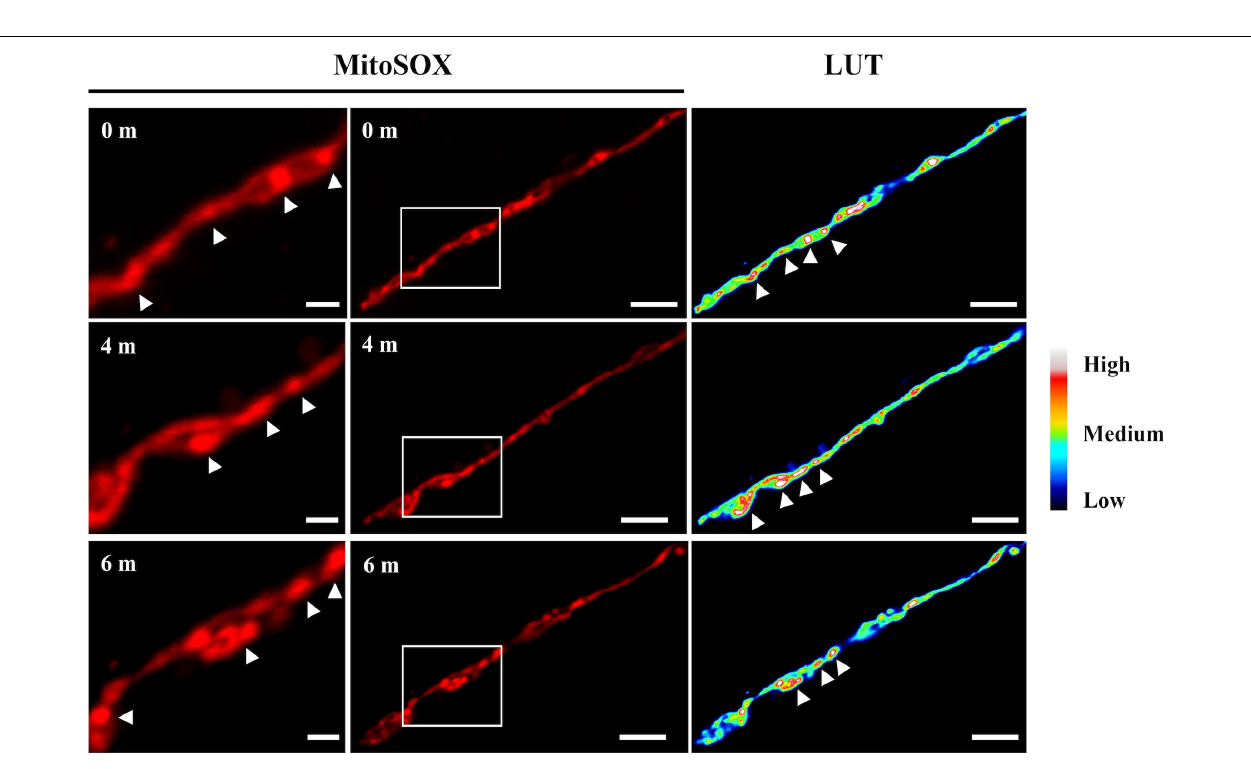
Frontiers in Microbiology |